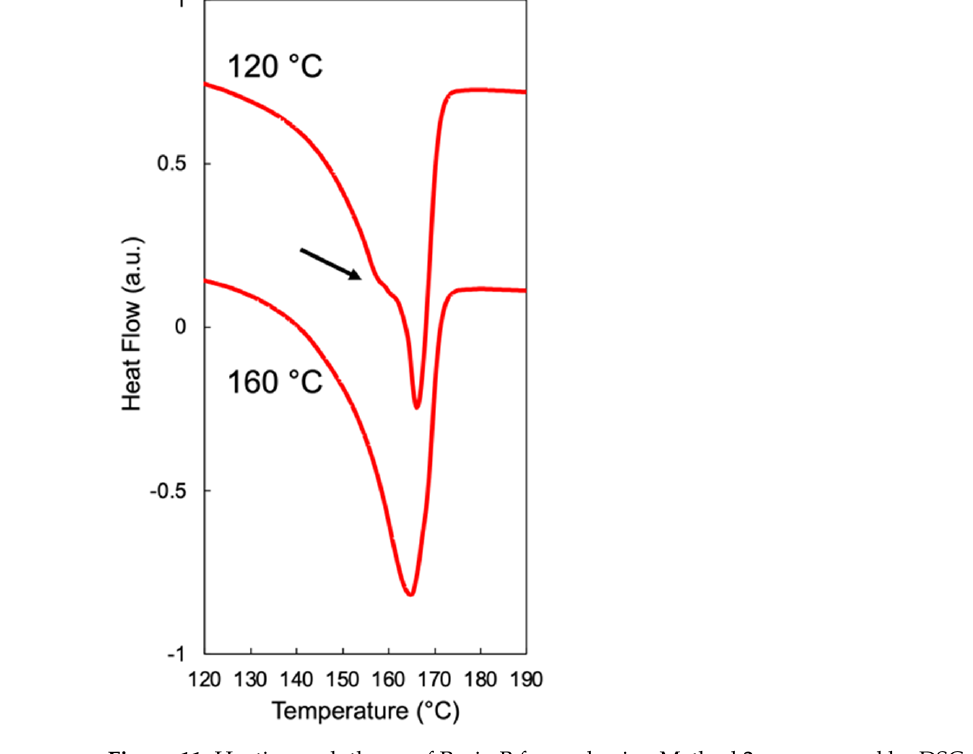
Figure 11. Heating endotherm of Resin B foamed using Method 2 as measured by DSC. Shoulder in the DSC curve of the sample foamed at 120 °C reflects the formation of crystals during cooling.